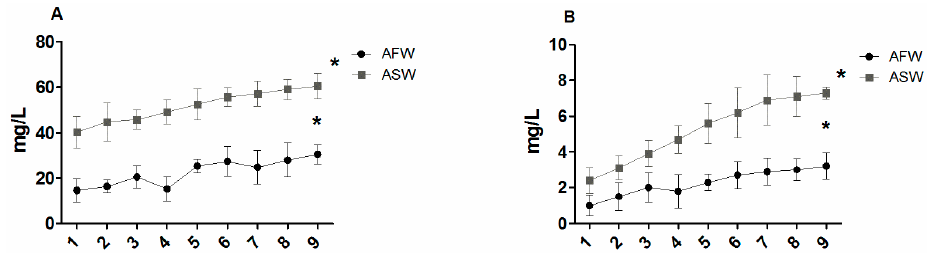
Figure 1. Trend of NO 3 ( A ) and PO 4 ( B ) measured during the trial in two aquaponic systems (aquaponic freshwater, AFW and aquaponic saltwater, ASW). Knots represent the means of triplicate groups; bars indicate SD. Statistical significance is labelled with asterisks ( p < 0.05).